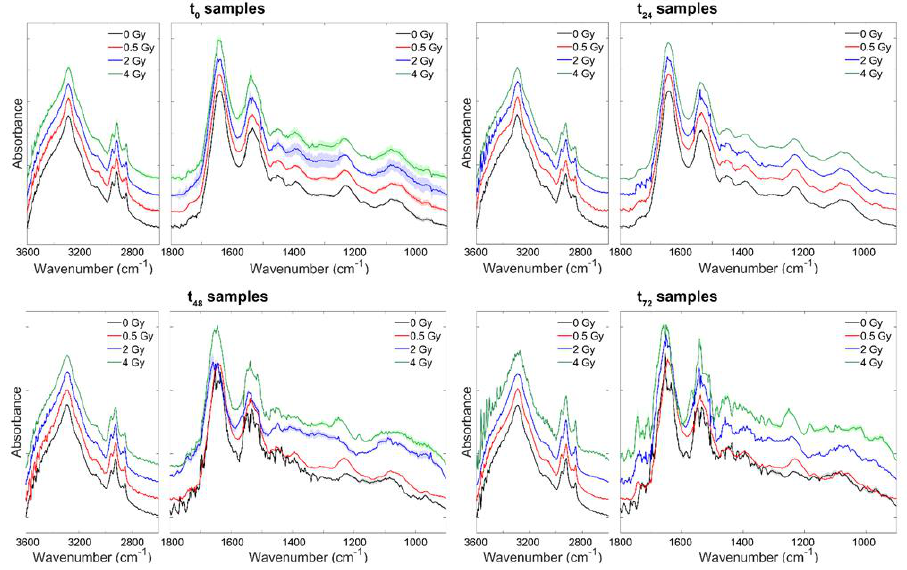
Figure 1. Comparison of the average spectra for unexposed and proton-exposed MCF-10A cells in the 3600–2600 cm −1 and 1800–900 cm -1 ranges at different proton doses (0.5, 2, and 4 Gy) for different fixation times. Data are reported as Mean ± SD. For each dose, three slides were tested. On each slide, at least three regions were investigated, and three spectra were obtained for each position.